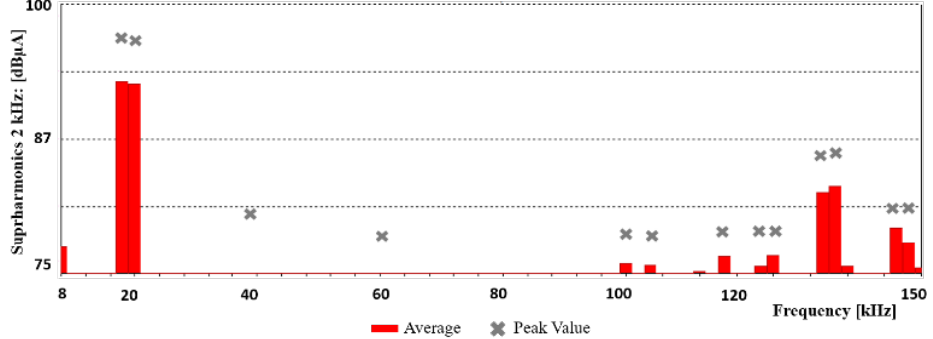
Figure 10. Supraharmonic emissions from 9–150 kHz according to IEC61000-4-30 Ed.3 modified to gapless method [14].